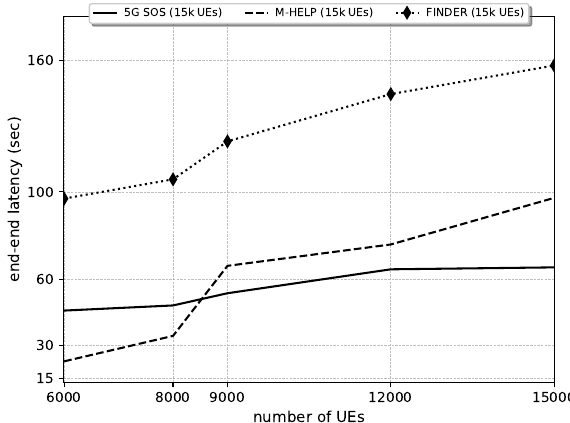
Figure 11. Comparison of end–end latency against NoU under 5G-SOS, M-HELP, and FINDER. Parameters: NoU: 6000 to 15,000, NEC: 5000, ETI: 1800 s (30 min).